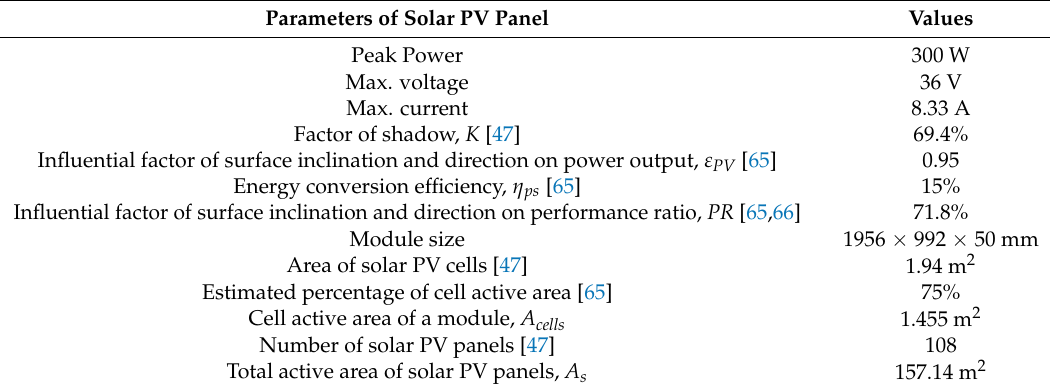
Table 4. Specific parameters of the solar PV panel.